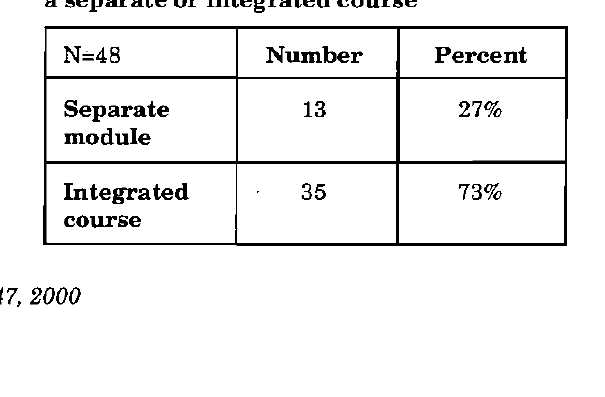
Dysphagia included